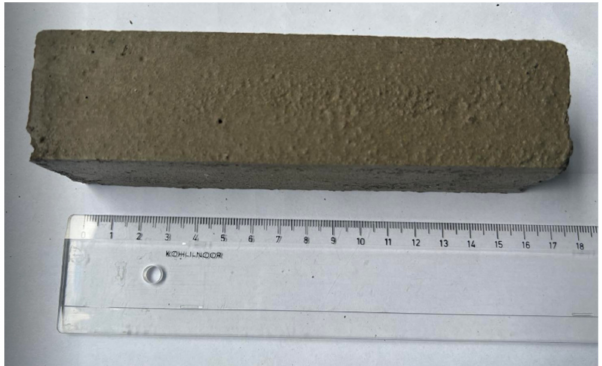
Figure 11. Geopolymer with MSWIBA.